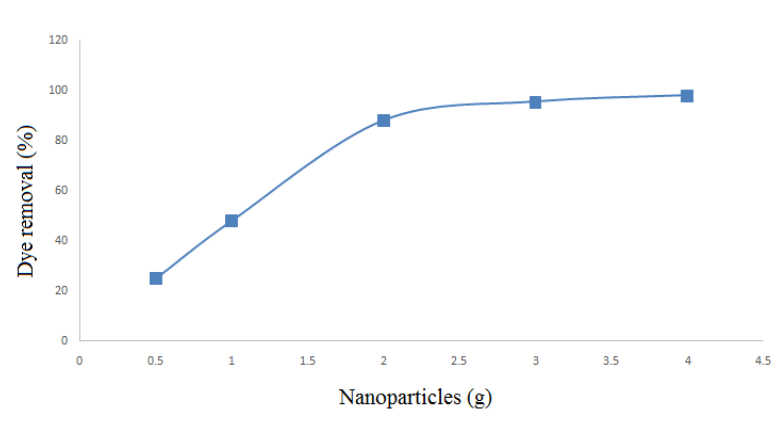
Fig 7. Effect of nanoparticles on process efficiency. (Contact time: 40 min, pH=4, initial dye con- centration of 57 mg/L, hydrogen peroxide concentration of 200